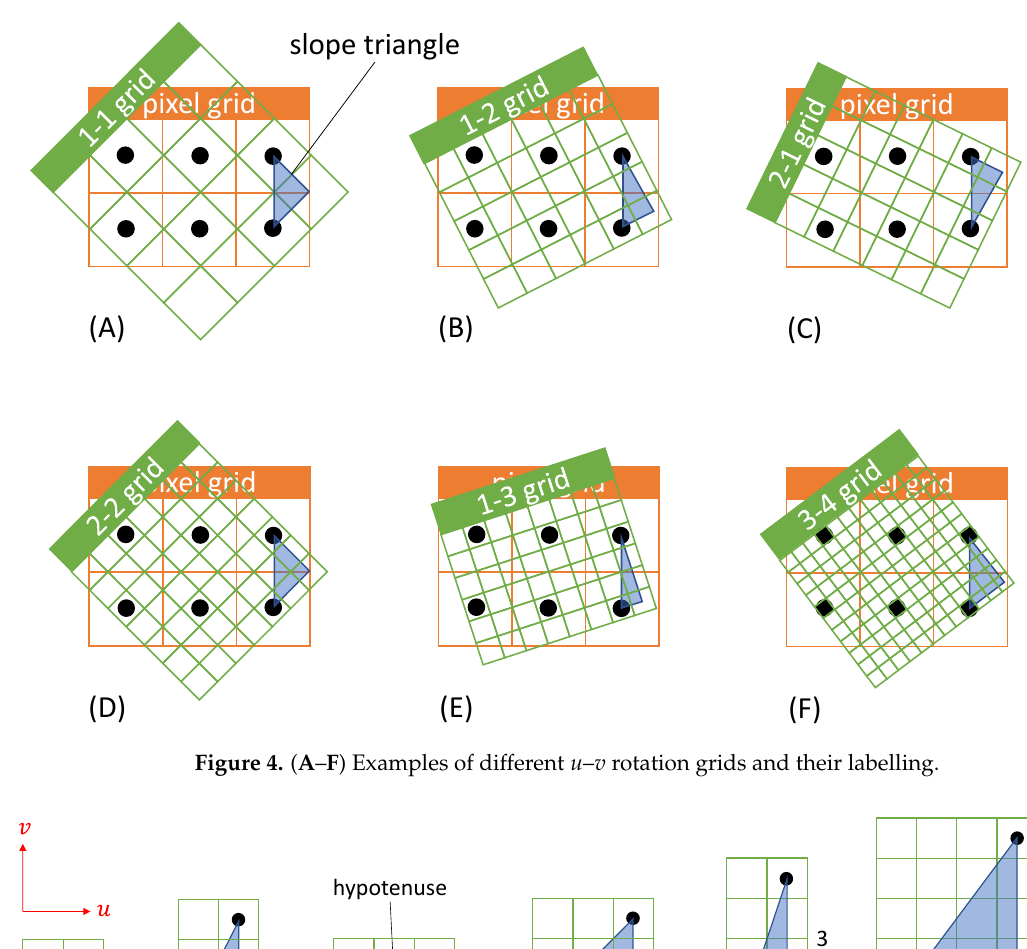
Figure 5. Slope triangles for classification of 𝑢 – 𝑣 grids for examples ( A – F ) according to Figure 4.